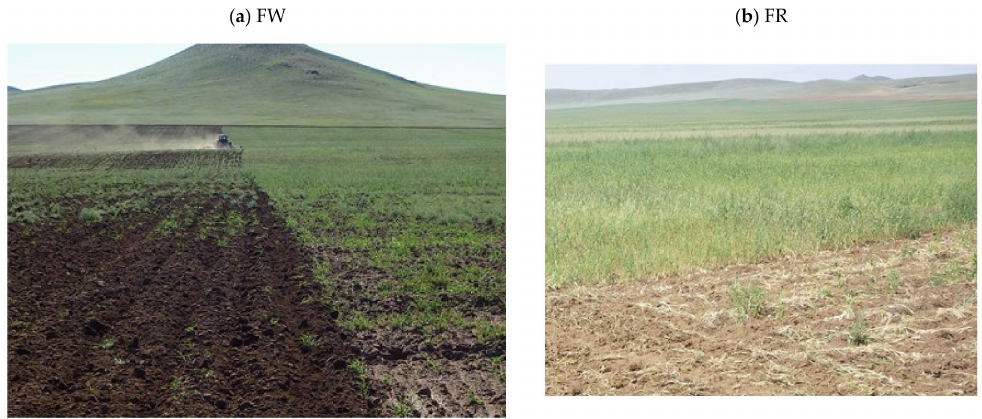
Figure 12. Photographs of ( a ) FW and ( b ) FR, which were plowed in mid-August